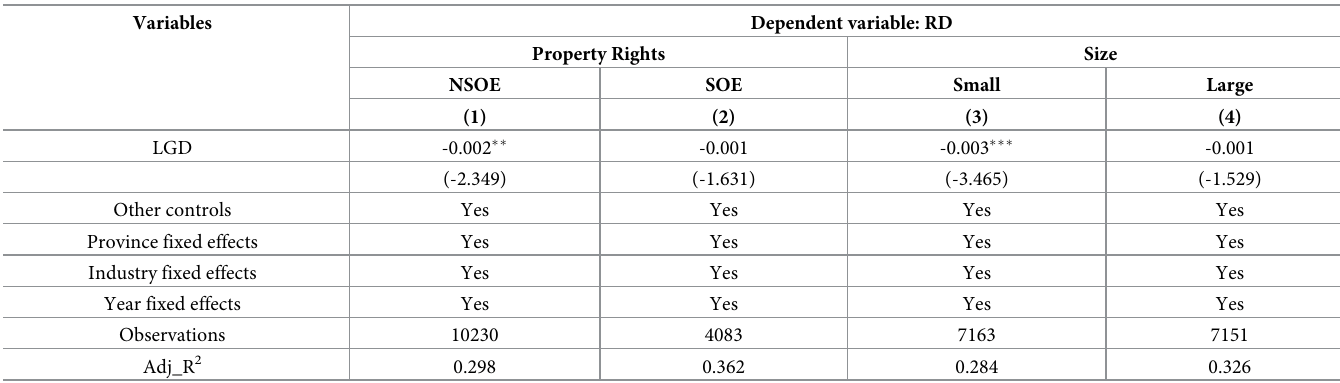
Table 6. Cross-sectional analysis 1.